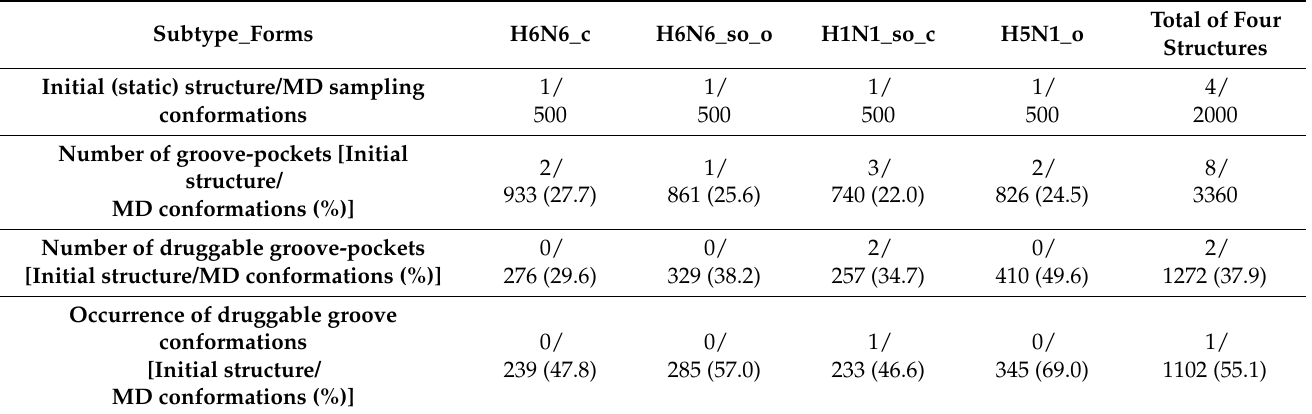
Table 1. Number of groove-pockets (total or druggable) and groove conformations, according to the four forms of NS1 (H6N6_c, H6N6_so_o, H1N1_so_c, H5N1_o) obtained in the initial static PDB structures and on a set of 500 conformations sampled during the MD